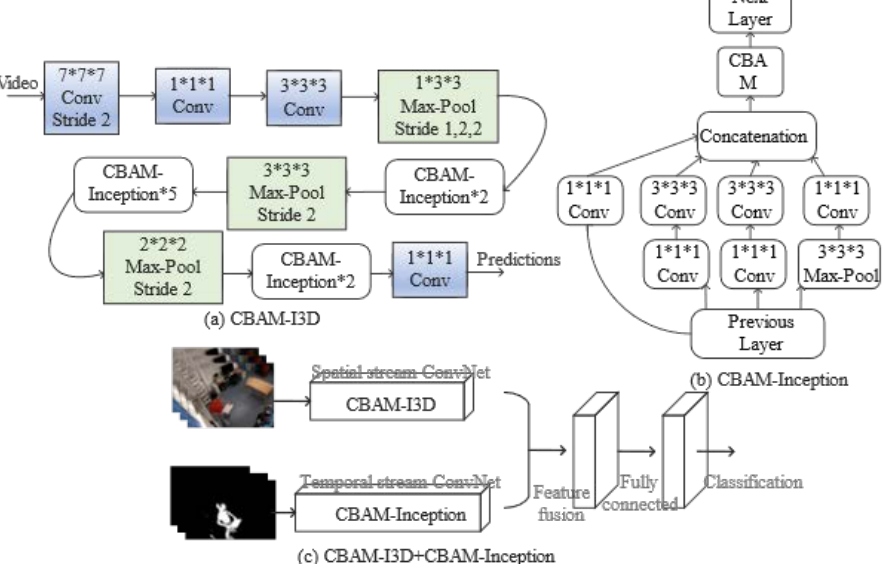
Figure 6. ( a ) CBAM-I3D network ( b ) CBAM-Inception network ( c ) Fusion two-stream heterogeneous 3D convolution and attention mechanism network.